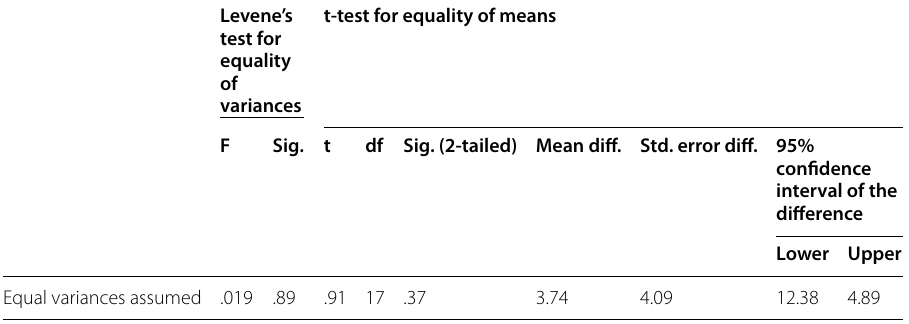
Table 7 Independent samples T-test between ectenic and synoptic learners in SI group